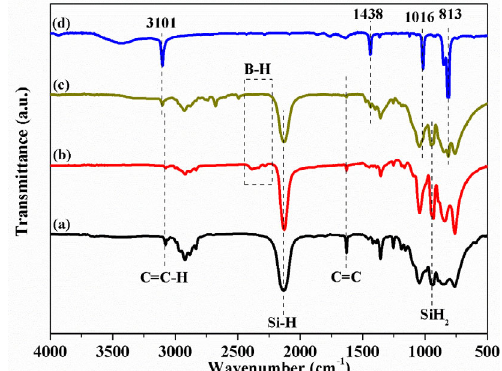
Fig. 1 FT-IR spectra of (a) original AHPCS, (b) AB, (c) ABZ-1, and (d) Cp 2 ZrCl 2 .